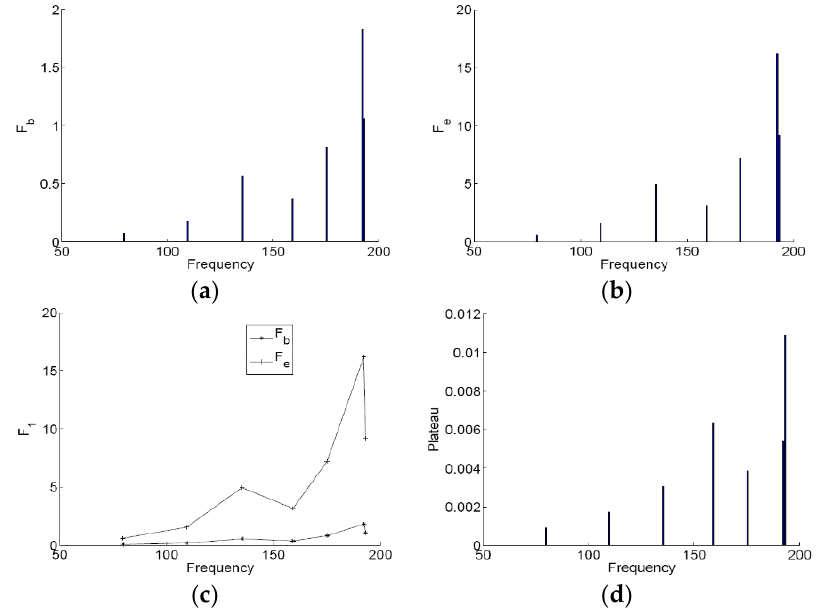
Figure 17. The two thresholds 𝐹 𝑏 and 𝐹 𝑒 and the plateau of the system composed of each mode coupled by the membrane. ( a ) the threshold 𝐹 𝑏 , ( b ) the threshold 𝐹 𝑒 , ( c ) the desired working zone and ( d ) the amplitude of the plateau.